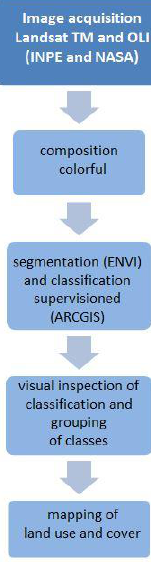
Figure 2. Flowchart of the methodological steps of land use and land cover